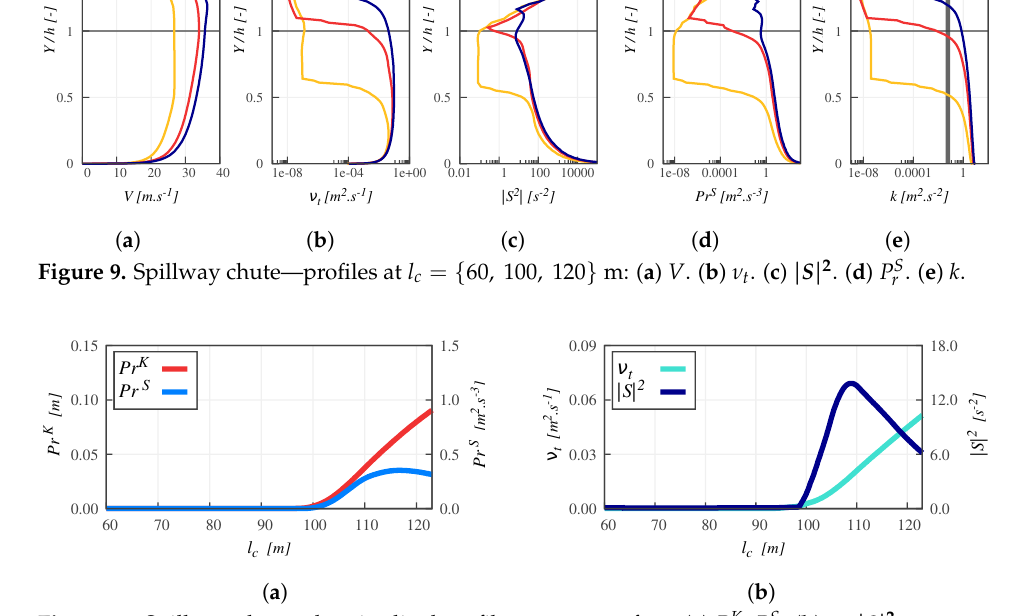
Figure 10. Spillway chute—longitudinal profile at water surface: ( a ) P K r , P S r . ( b ) ν t , | S | 2